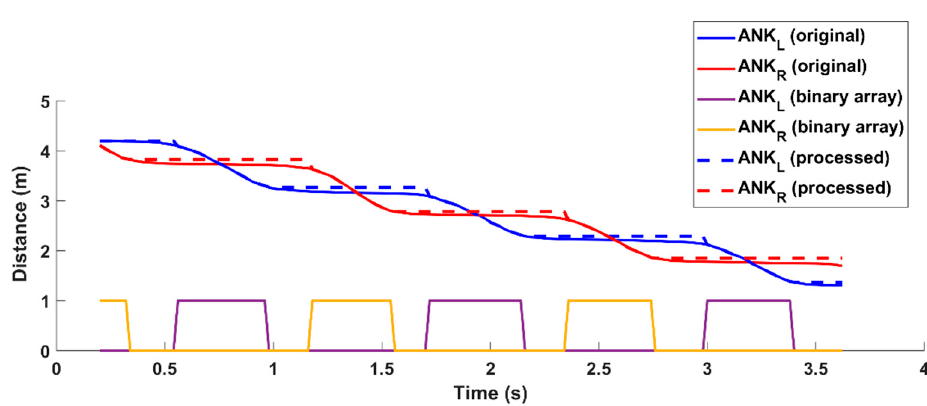
Figure 4. Estimation of binary arrays from the trajectories of ankle joints within the time window used for the analysis. Solid red and blue lines refer to the original trajectories of ankles; dotted red and blue lines refer to the processed trajectories with constant Z component during the stationary condition. The graph also shows the solid yellow and purple square lines corresponding to the two binary arrays to highlight the “stationary” (0 values) and the “in movement” (1 values) periods. The two binary arrays are then used to extract meaningful information on gait patterns corresponding to traditional spatiotemporal parameters of gait analysis [39,56,68]. Figure 5 shows the result estimated by the analysis procedure from the binary arrays, i.e., the sequence of the left and right steps, and some temporal values.